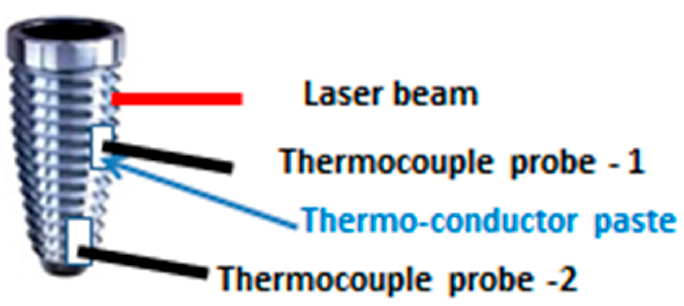
Figure 3. Setup for the assessment of the temperature increase measurements on a contaminated dental implant. The thermocouple probes placed in close contact with the apical region and at 1 mm from the irradiation area of implant